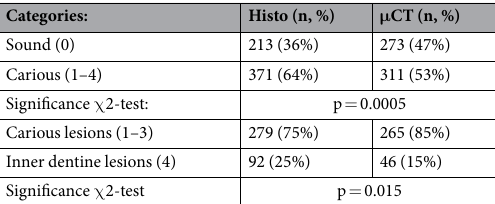
Table 3. Dichotomizing surfaces between lesion categories detected with histology (Histo) or micro-CT ( μ CT) as given below yielded a significant χ 2 test.